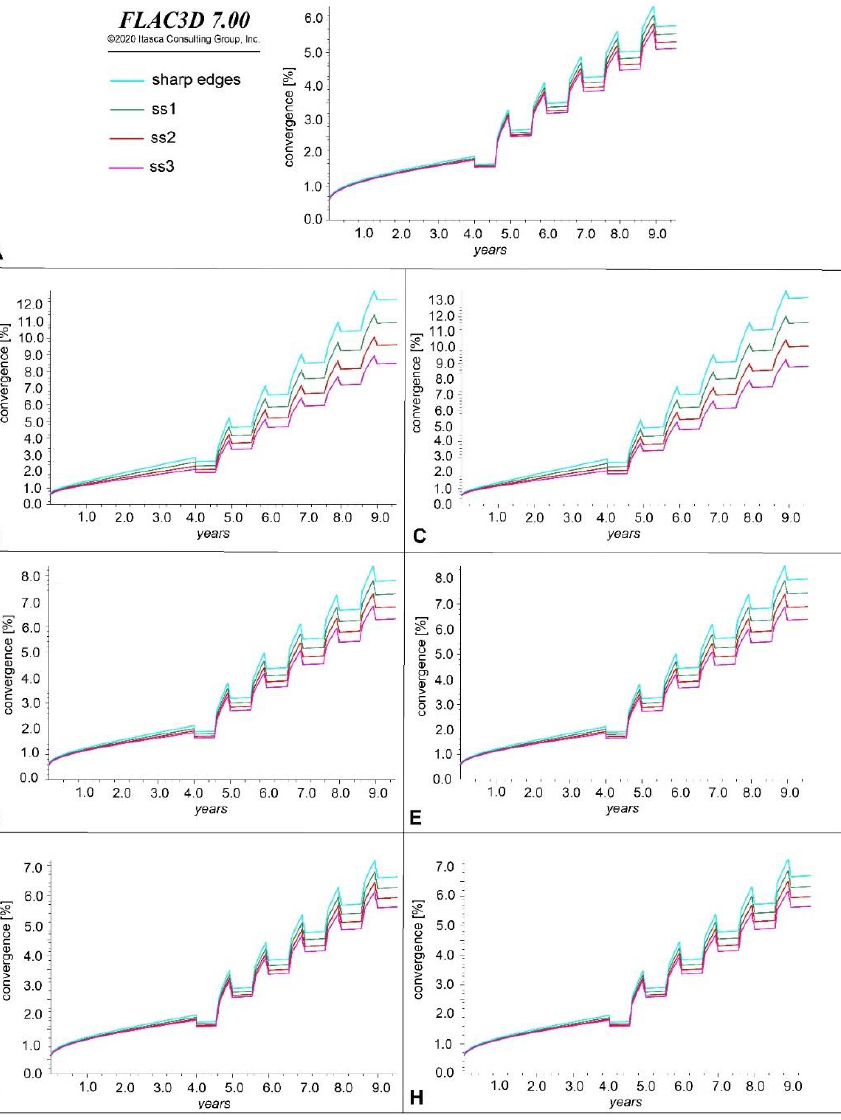
Figure 23. The volumetric closure (convergence) in simulated caverns: ( A ) cylindrical, ( B ) enlarged top, maximum initial diameter of 120 m, ( C ) enlarged bottom, maximum initial diameter of 120 m, ( D ) enlarged top, maximum initial diameter of 90 m, ( E ) enlarged bottom, maximum initial diameter of 90 m, ( F ) enlarged top, maximum initial diameter of 75 m, ( H ) enlarged bottom, maximum initial diameter of 75